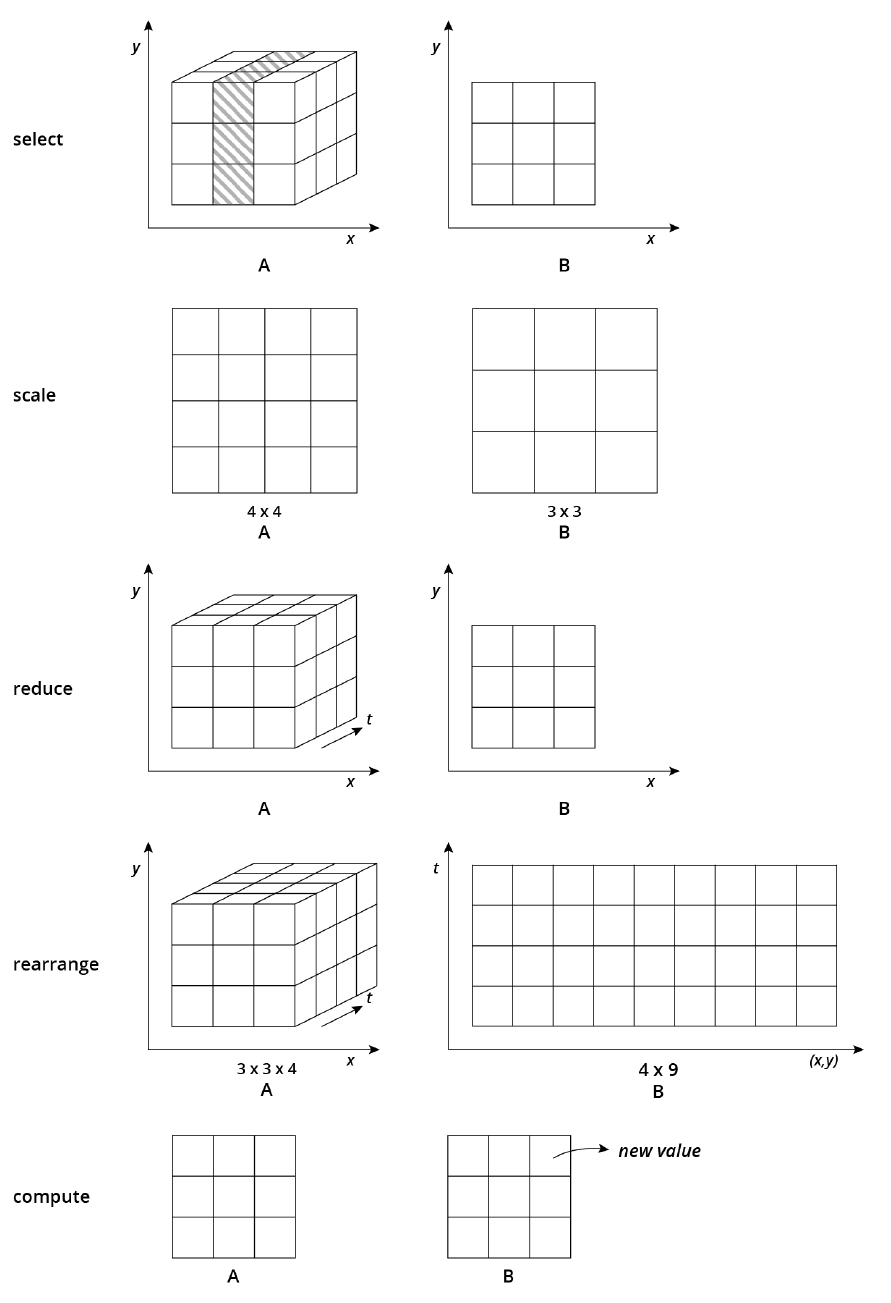
Figure 2. Array operations, from top to bottom: select, scale, reduce, rearrange and compute operations. “A” indicates original arrays, “B” indicates result arrays after certain array operations are applied. The application of “reduce” functions changes array cardinality, the application of “rearrange" functions alters array